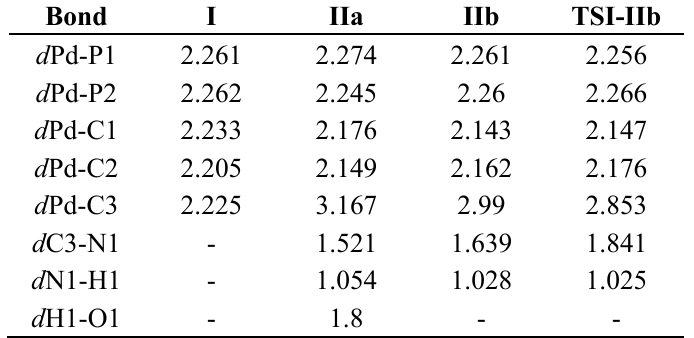
Table 1. Bond lengths (Å) of the calculated structures of intermediates involved in nucleophilic